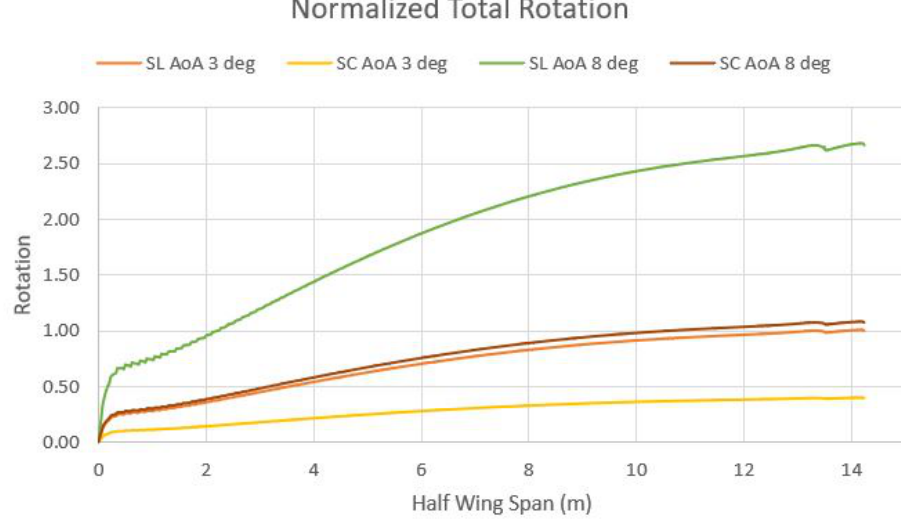
Figure 14. Total Rotation on half-wing span.